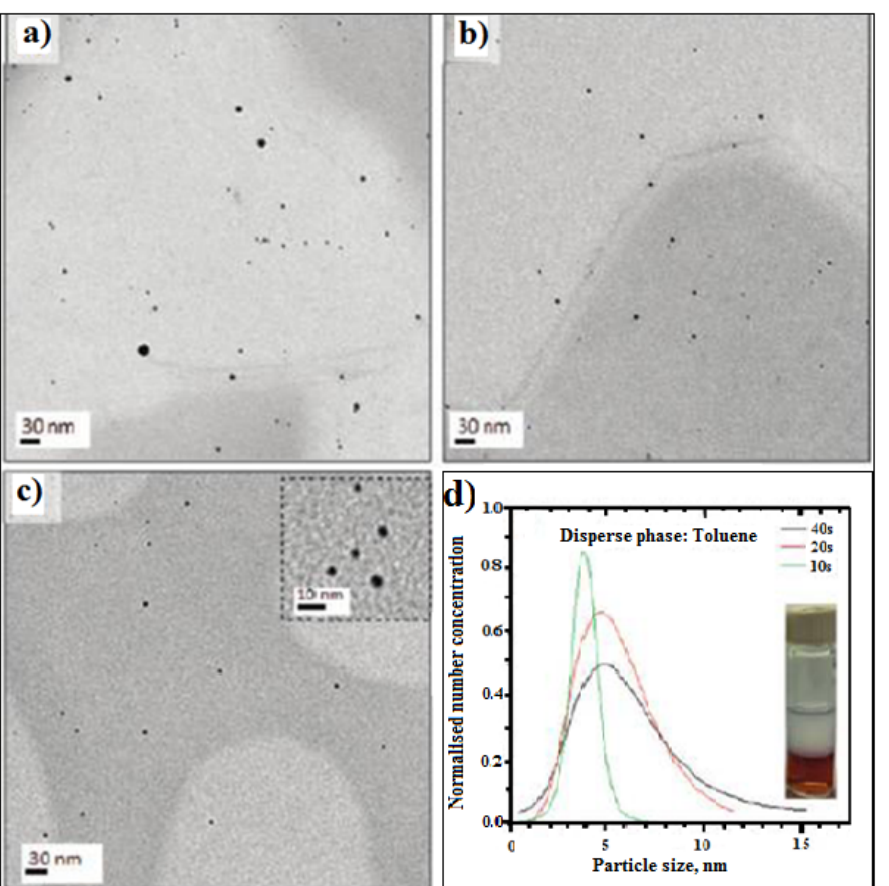
Figure 24. TEM image of gold NPs synthesized in toluene-aqueous segmented flow: ( a ) [Au] = 1 mM; ( b ) Rt = 40 s; ( c ) Rt = 20 s; ( d ) Rt = 10 s. Particle size distribution diagram from AuNPs obtained in toluene-aqueous segemented flow at Rt = 40, 20, and 10 s, [Au] = 1 mM. Inset: gold NPs obtained in the toluene-aqueous phase, Rt = 10 s. Bottom: segmented slugs generated at Rt = 10 and 40 s (fluorescein was added to improve the optical